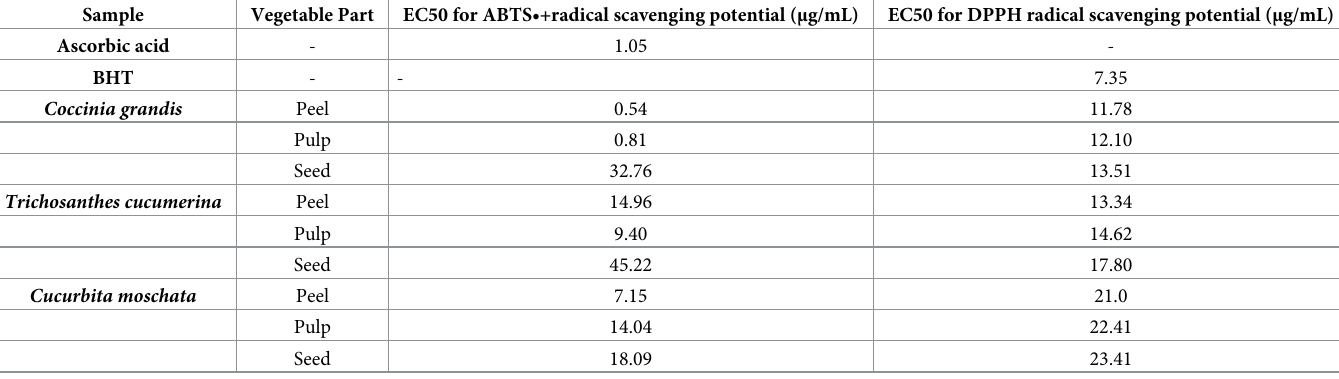
Table 5. Means EC50 values for ABTS•+ and DPPH radical scavenging potential of the aqueous extracts of various parts of studied Cucurbitaceae vegetables. Sample